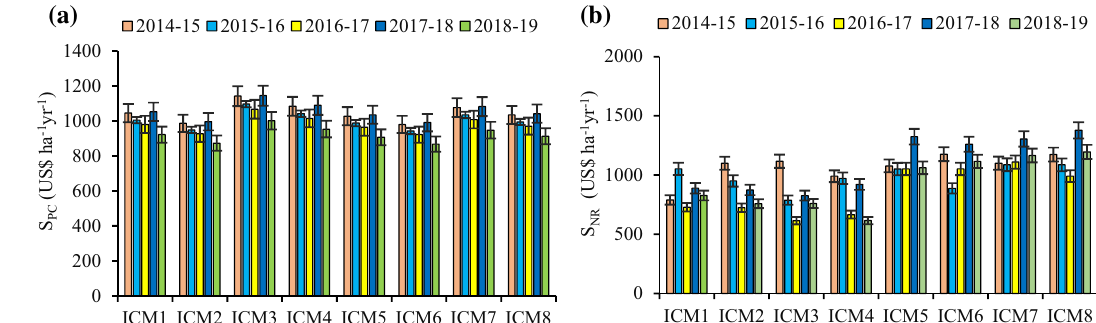
Figure 3. Five years’ trend in system variable production costs (S PC ) ( a ) and net returns (S NR ) ( b ) under different ICM modules in the maize–wheat rotation. The vertical bars indicate LSD at p = 0.05.